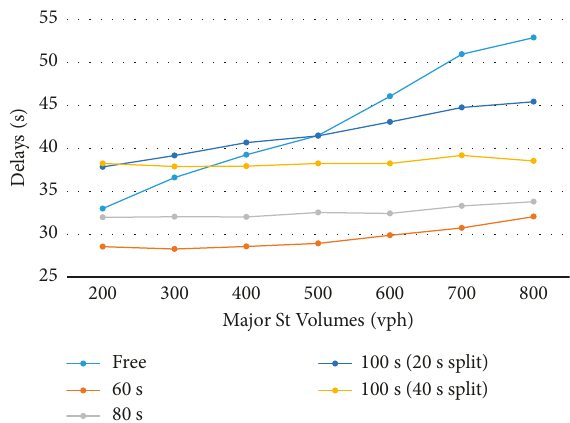
Figure 3: Average delay under minor street volume of